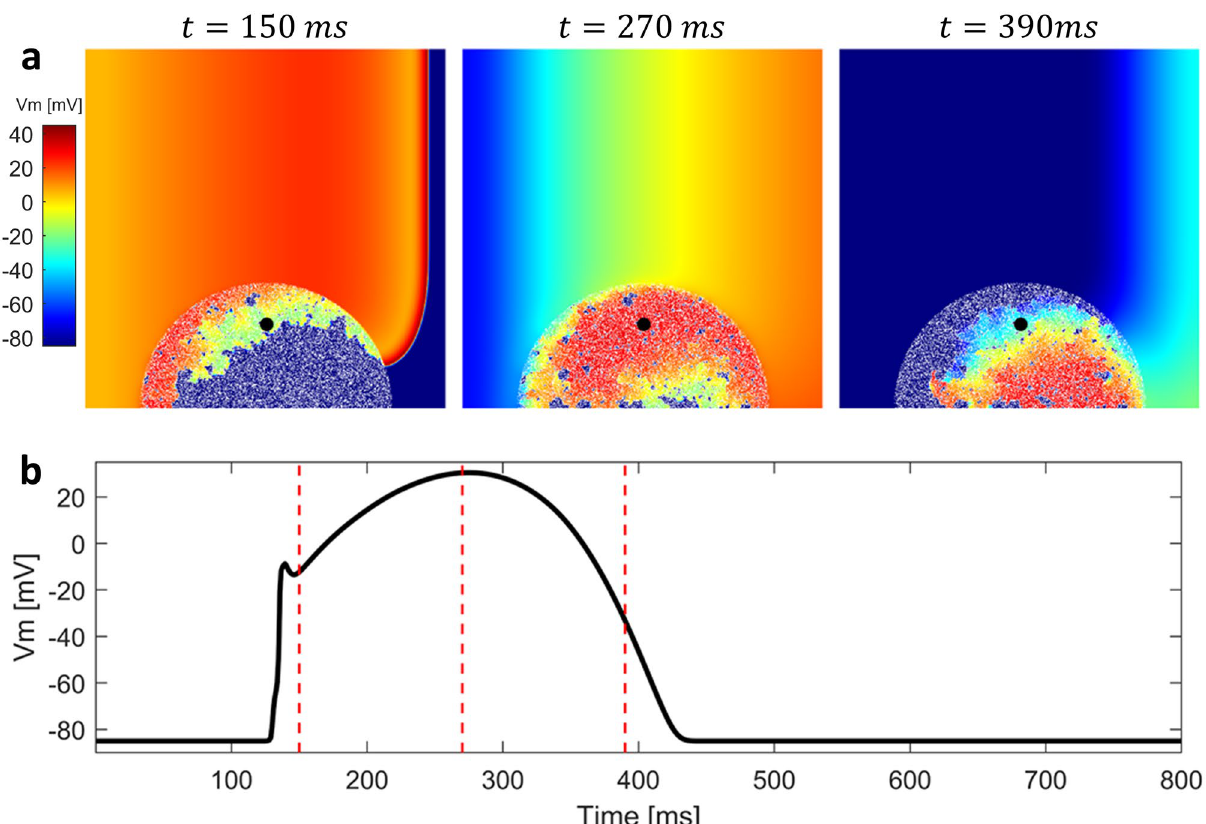
Figure 7. Failure to trigger sustained reentry when AP dome is always maintained. ( a ) Sequence of snapshots 0 taken from the 10 × 10 cm tissue model. The value of d w was 0.6, whereas the radius of the BrS region was 3.5 cm. Percentage of fibrotic tissue was set to 35% . Sustained reentry was not induced. ( b ) Membrane potential in the BrS region recorded in the point indicated by a black dot in the snapshots. The presence of the dome in the AP prevents orthodromic reentry. Red dashed lines indicate the time instants at which snapshots were